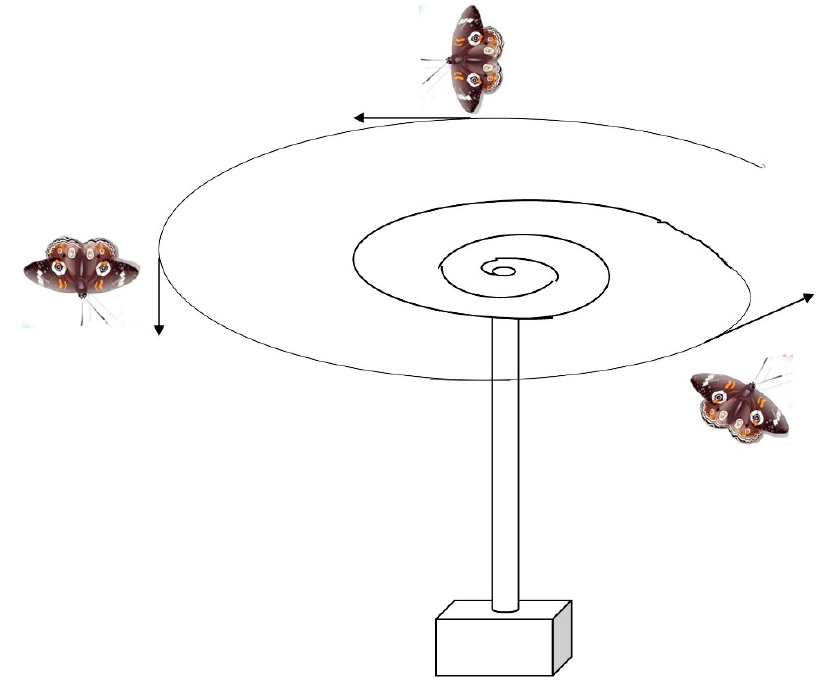
Figure 1. The flight trajectory of moths around the light source.